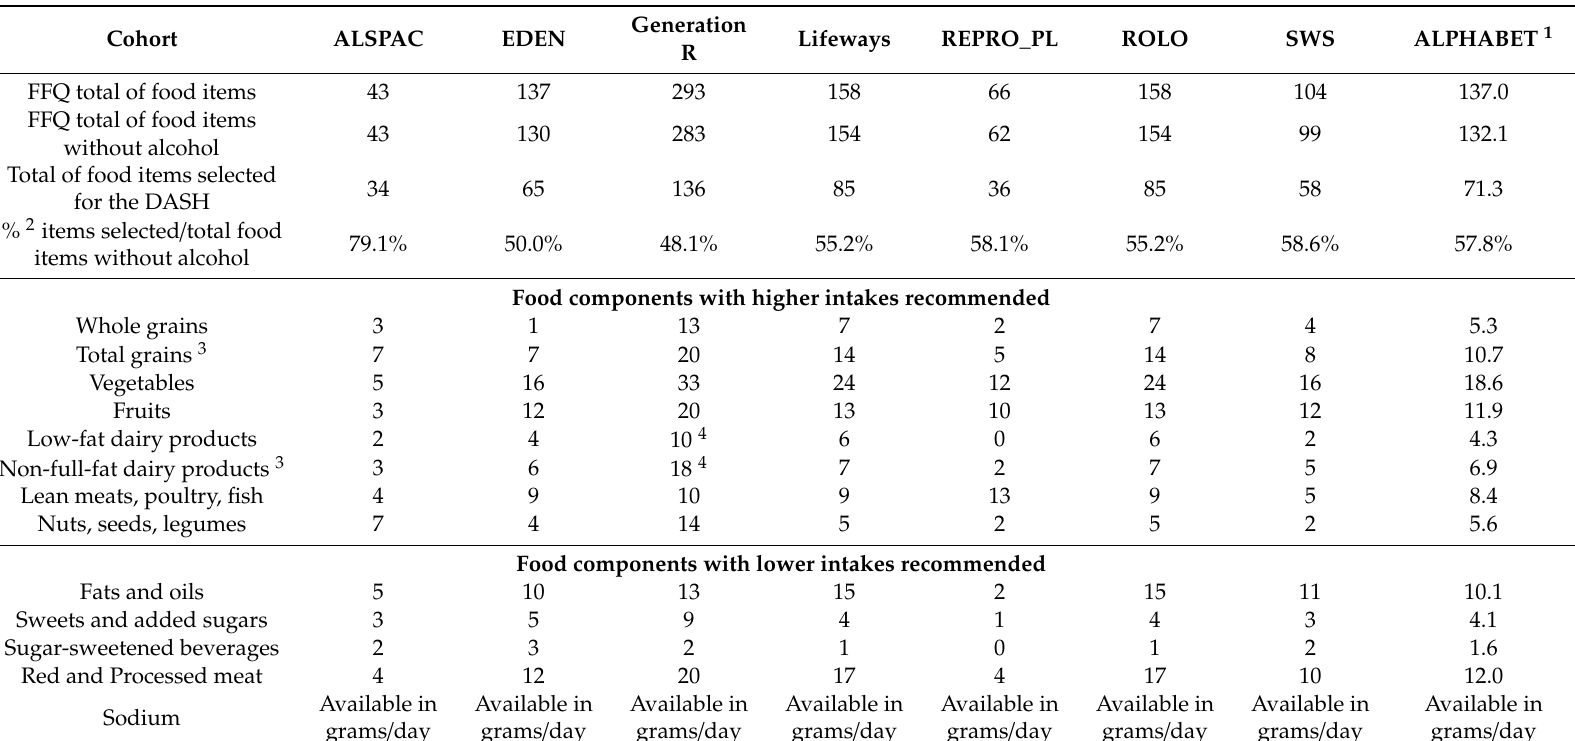
Table 2. Availability of FFQ data for each